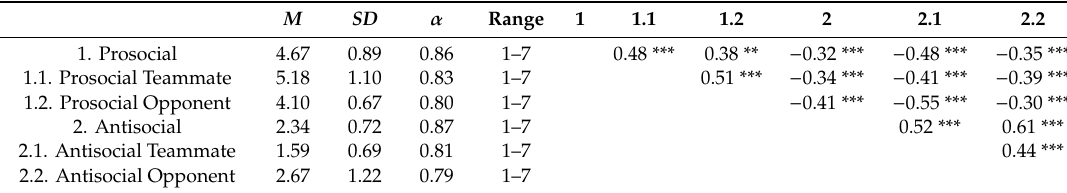
Table 3. Descriptive statistics and bivariate